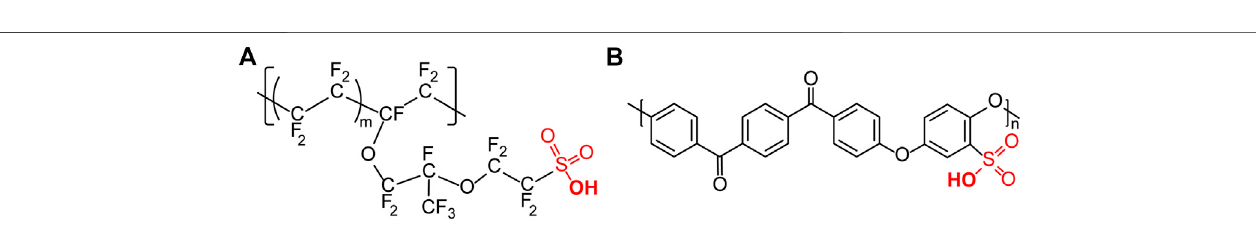
Frontiers in Energy Research |